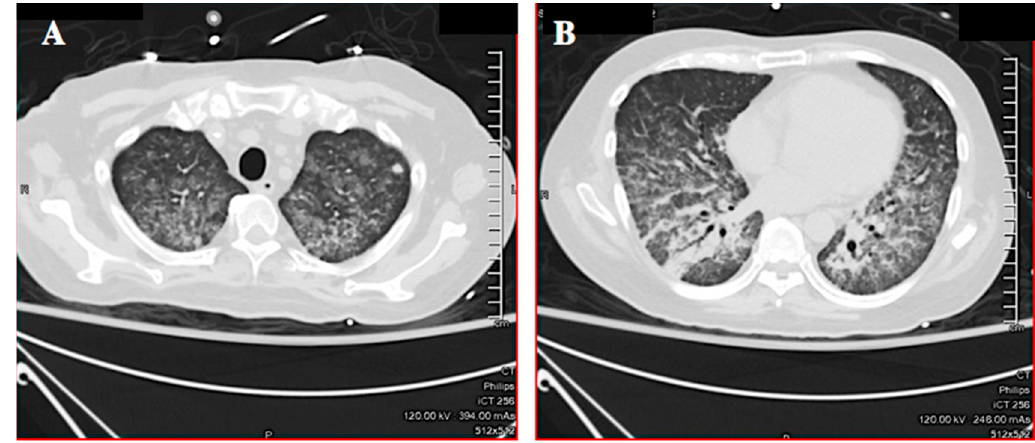
Figure 2. Case 1: CT scan of the chest showing diffuse ground glass airspace opacities, interlobular septal thickening ( A ), and a right middle lobe cavitary lesion ( B ). The airspace opacities suggested diffuse alveolar hemorrhage.